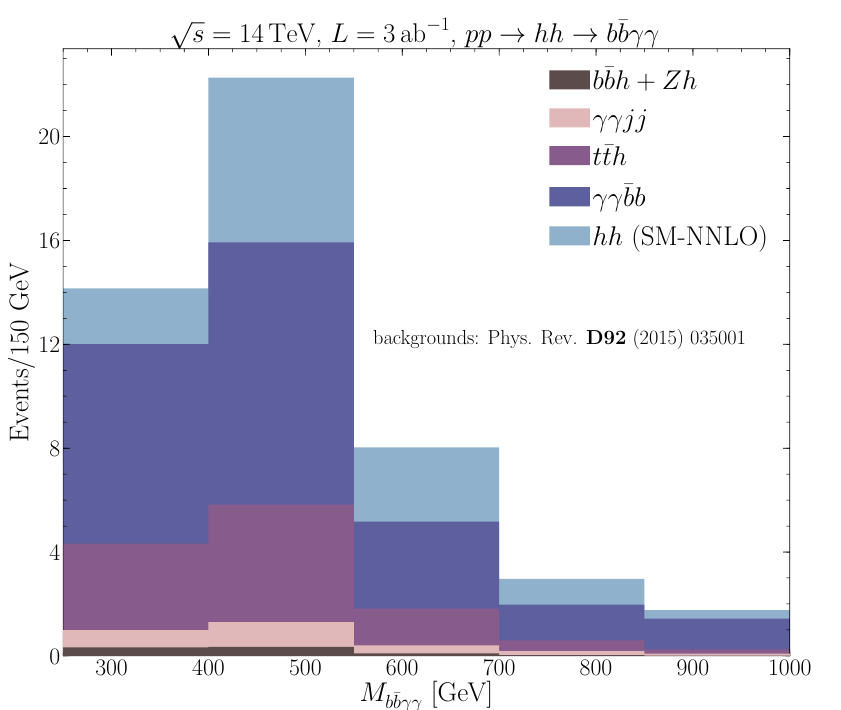
Figure 11 . The number of expected events in SM hh signal with the most relevant backgrounds as estimated by